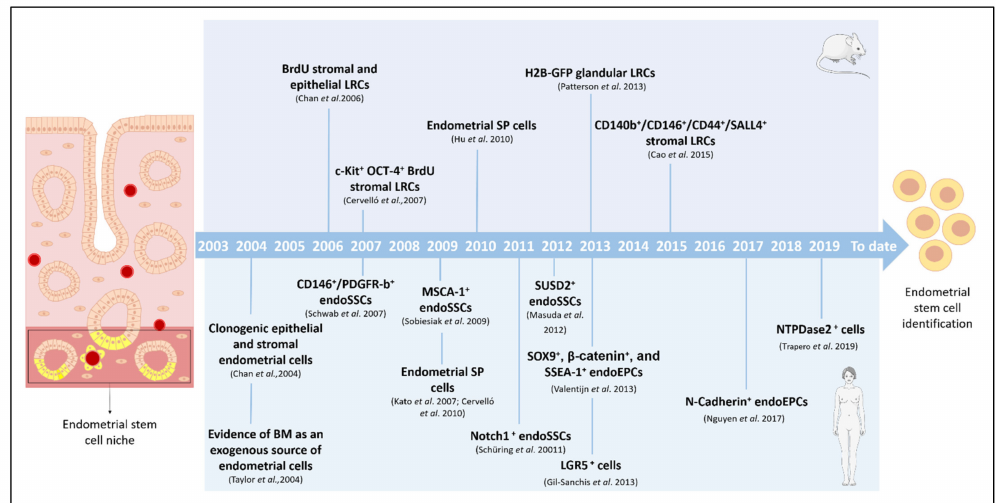
Figure 1. Milestones in the identification, isolation, and characterization of endometrial stem cells. Timeline of the principal findings concerning endometrial stem cells and specific isolation techniques in murine and human models. BM: bone marrow; BrdU: bromodeoxyuridine; CD: cluster of differentiation; endoSSCs: endometrial stromal stem cells; endoEPCs: endometrial epithelial progenitor cells; GFP: green fluorescent protein; H2B: histone 2B; LRCs: label-retaining cells; LGR: leucine-rich repeat containing G-protein-coupled receptor; MenSCs: menstrual blood stem cells; NTPDase2: ectonucleoside triphosphate diphosphohydrolase-2; SSEA-1: stage-specific embryonic antigen-1; SP: side population; SUSD2: sushi